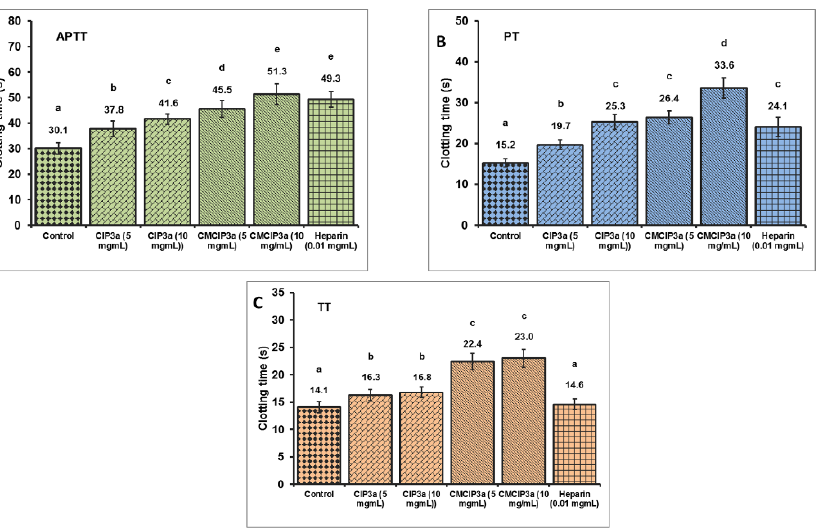
Figure 9. In Vitro anticoagulant properties of CIP3a and CMCIP3a. Values with no letters in common in each clotting test ( A – C ) (APTT, PT and TT) are significantly different ( p <